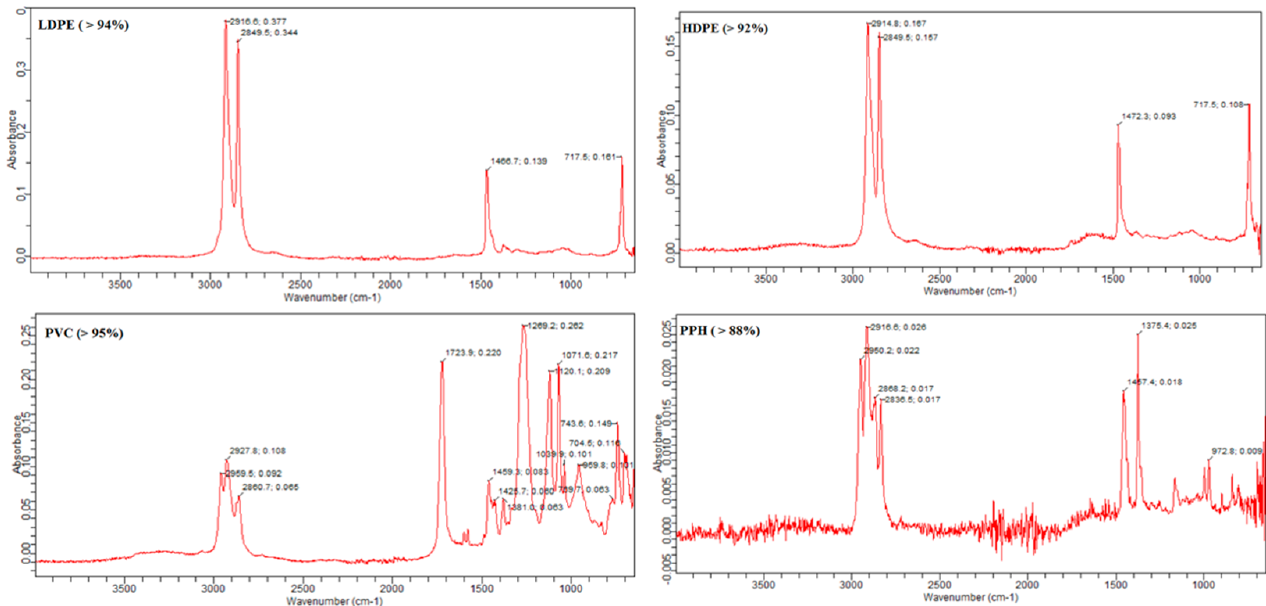
Figure 4. Relative abundance of three major particle shapes of the identified MPs recovered from the surface water and fish GIT samples.